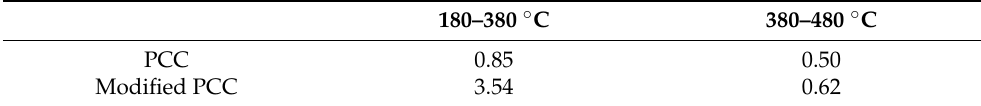
Table 1. Weight loss of PCC (wt.%) before and after modification between 180 and 480 °C.